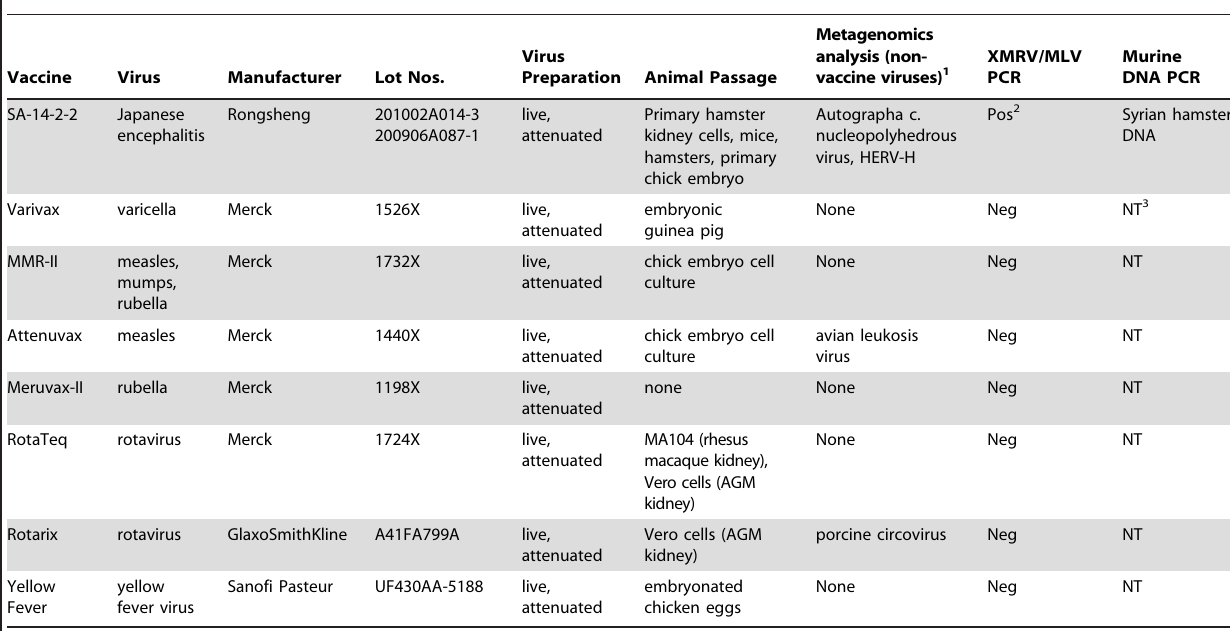
Table 1. Identification of Hamster DNA and Retroviruses in Eight Live, Attenuated Human Virus Vaccines.